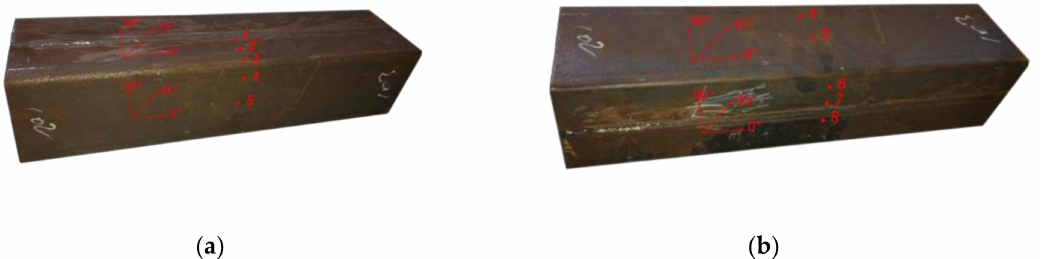
Figure 7. Test point location diagram of the welded box section RS1 specimen. ( a ) Points 1 to 4, ( b ) Points 5 to 8.